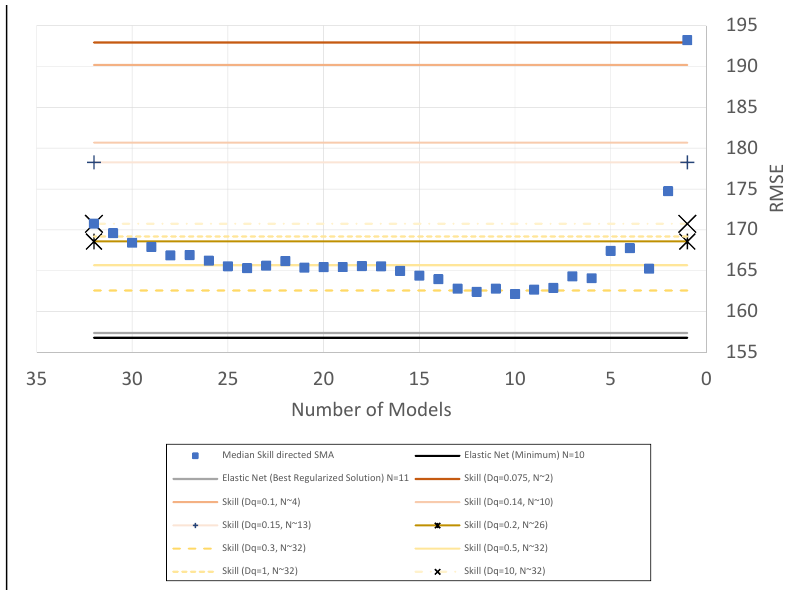
Figure 5. For the Willamette Valley American Viticultural Area (AVA) and growing season average temperature (GST), computed root mean squared error (RMSE) values obtained by comparing GST specific processed daily Localized Con- structed Analogs (LOCA) Coupled Model Intercomparison Project phase 5 (CMIP5) model historic datasets [40,41] with their equivalently processed observed data counterparts [18,42] using skill weighting, with various values for its radius of model equality, D q [17,23], model median skill directed simple model averaging (SMA), and elastic-net regularization [33]. N denotes the number of LOCA CMIP5 models defining the